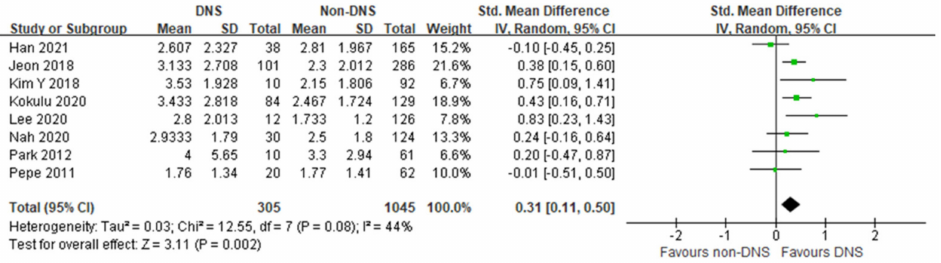
Figure 2. Forest plot of the association between early phase serum lactate level and occurrence of delayed neuropsychiatric sequelae in adult patients with acute carbon monoxide poisoning